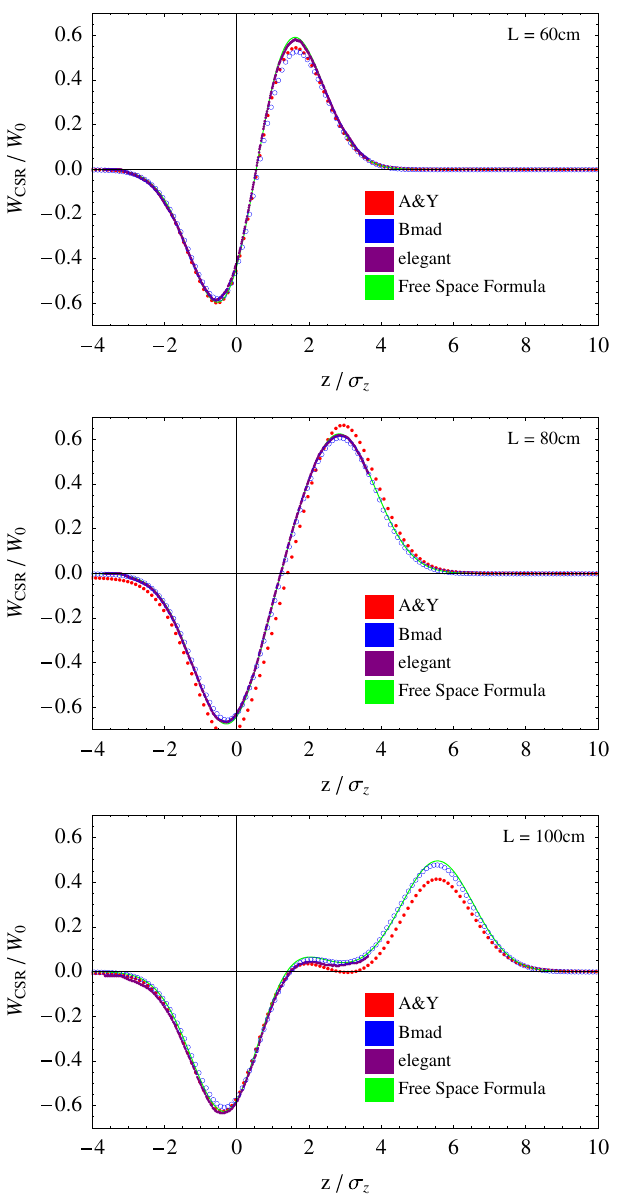
FIG. 12. (Color) Length dependence for the transient cases using a tall chamber by reversing width and height in parameter set D with magnet lengths of 60 cm (top), 80 cm (middle), and 100 cm (bottom).